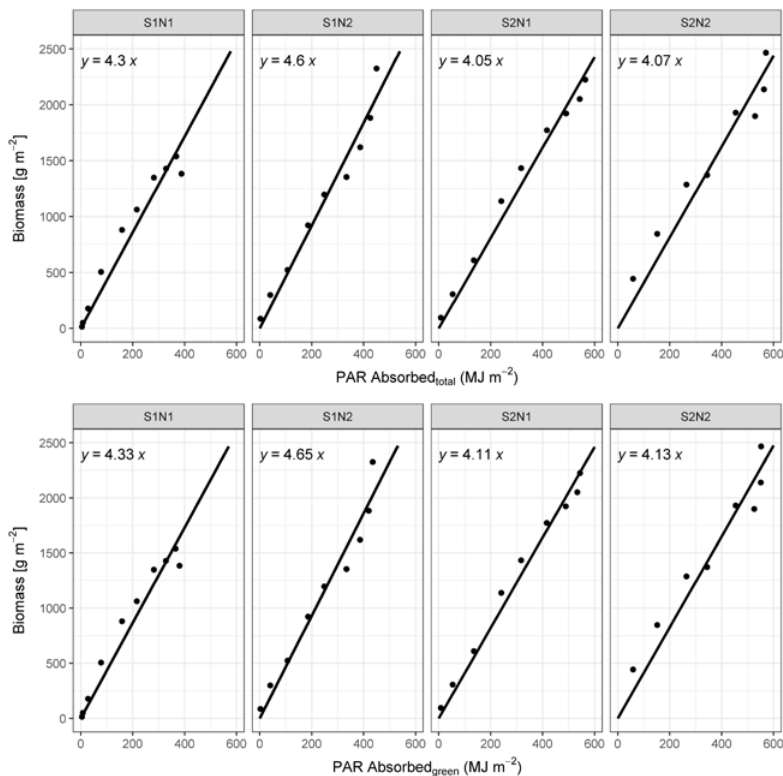
Figure 7. Cumulative maize aboveground biomass as a function of cumulative absorbed photosynthetically active radiation. The top row shows relationship per treatment based on APAR total , the bottom row based on APAR green . The slope of the estimated regression equation is the RUE. The intercept was suppressed.